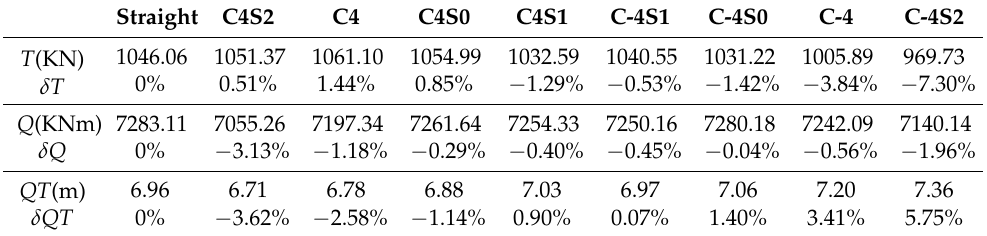
Table 3. Thrust and torque of different